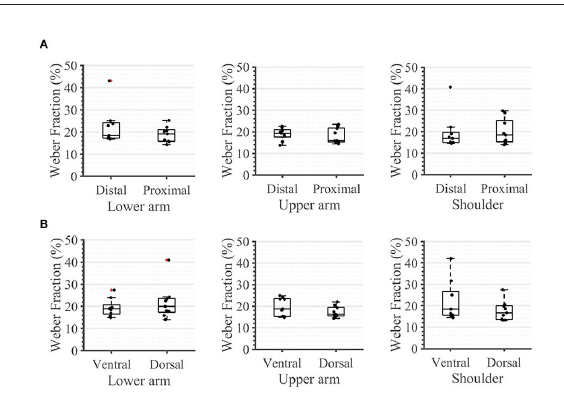
FIGURE10 Task 3 -Average performance in the compensatory tracking task for all subjects and conditions. Here, time delay (A) , average rectified error (B) , and correlation coefficient (C) between the target and cursor is shown ( n = 10). An asterisk indicates that there is a statistical difference ( p <